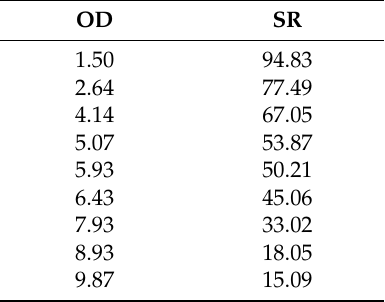
Figure 11. Linear fit of the spectral reflectance.